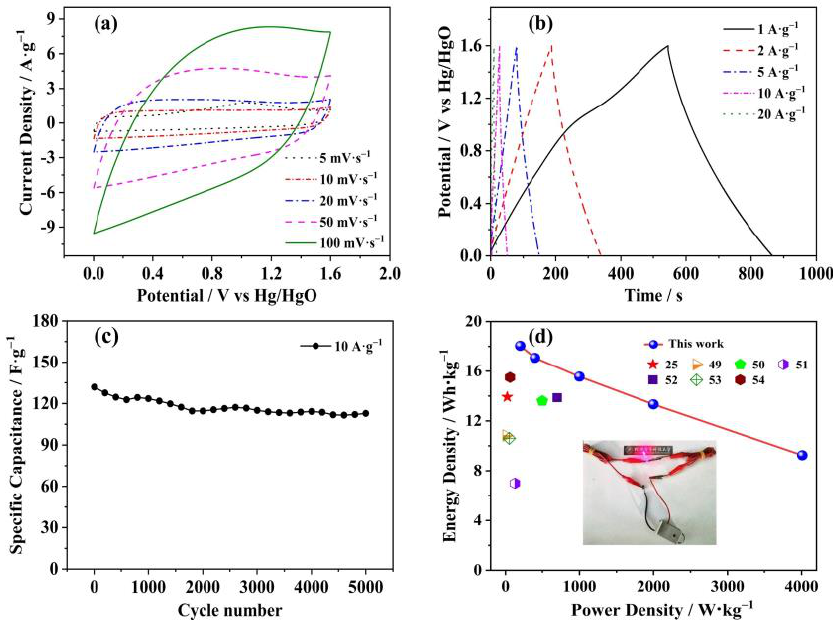
Figure 10. ( a ) CV curves at 5 – 100 mV·s −1 . ( b ) GCD curves at 1 – 20 A·g −1 . ( c ) Stable cyclic performance. ( d ) Ragone plots as compared to other studies and a supercapacitor device lighting up light-emitting diodes.